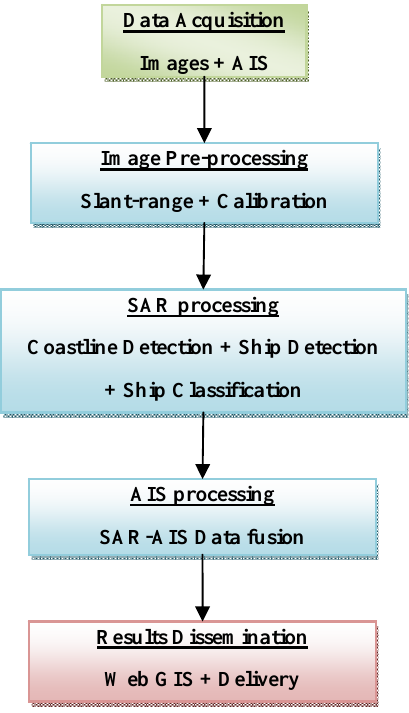
Figure 1. High level scheme of SIMONS.